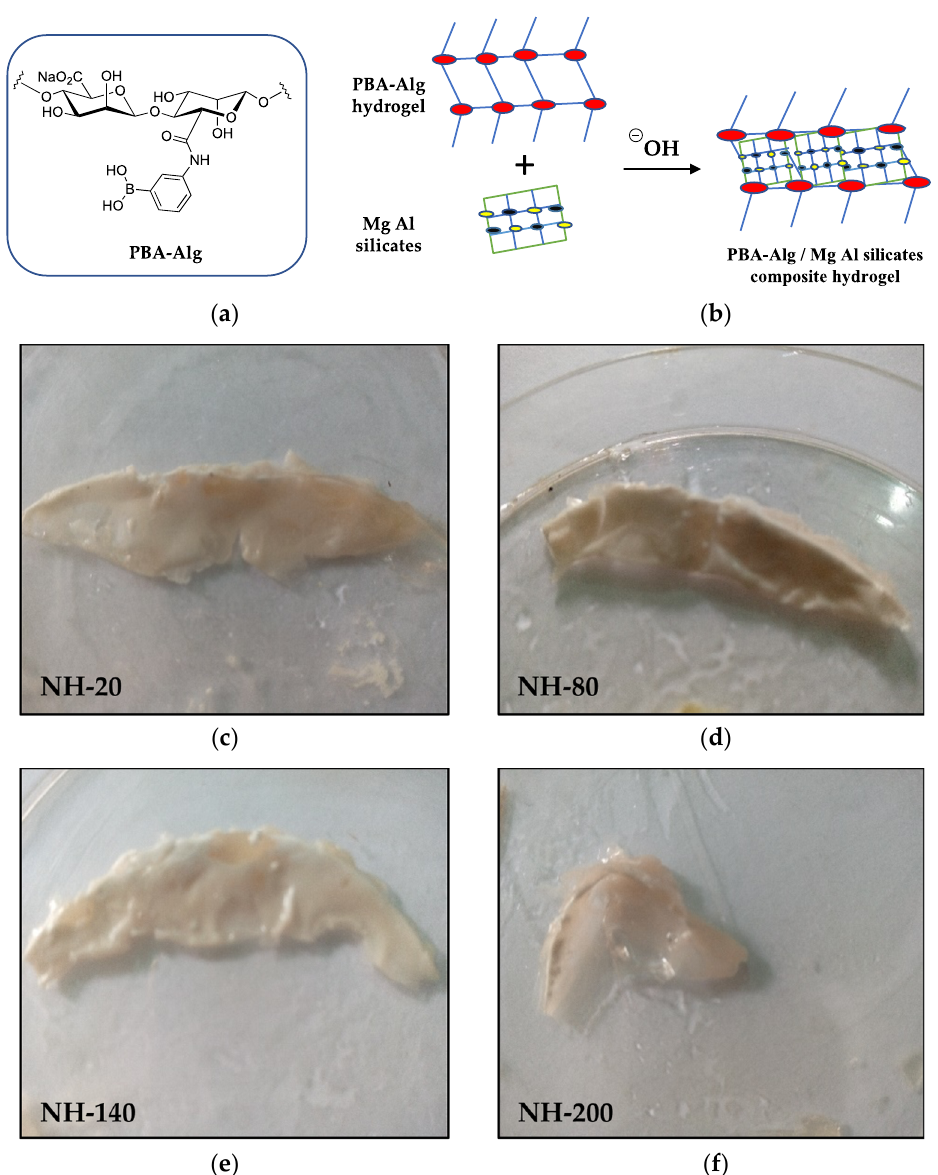
Figure 1. ( a ) Chemical structure of PBA-Alg conjugate used in this study. ( b ) Schematic representation of the composites. Images of formulated nanocomposite hydrogels labeled NH-20 ( c ), NH-80 ( d ), NH-140 ( e ), and NH-200 ( f ) representing composites with 20 mg, 80 mg, 140 mg, and 200 mg of magnesium aluminometasilicate, respectively, in combination with 50 mg of PBA-Alg.